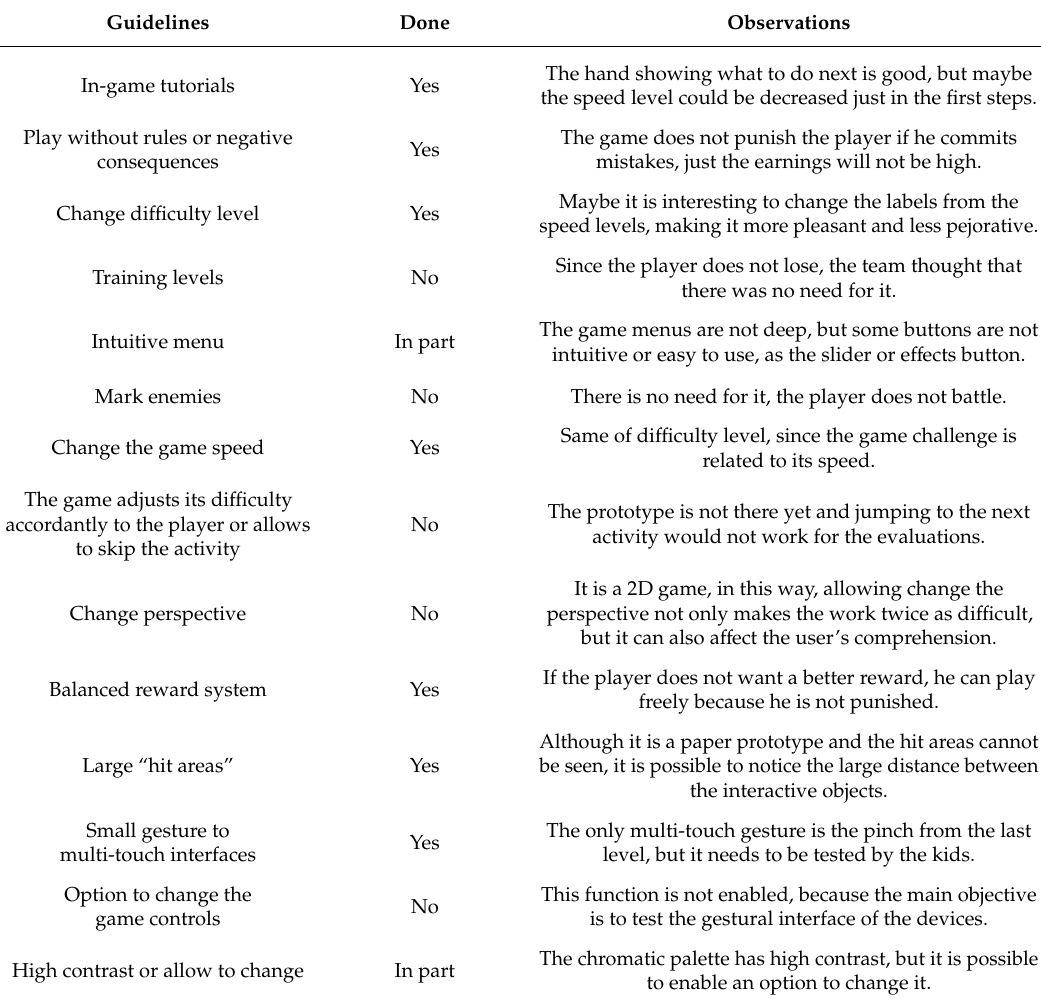
Table 13. Analysis of the guidelines from the book Includification [9].